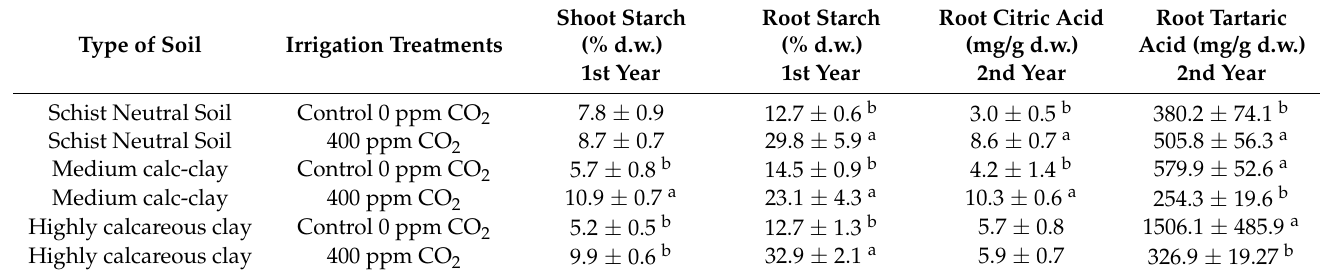
Table 8. Quantitation of shoot and root starch, and citric and tartaric acid in roots of V. vinifera (L.) cv. Tempranillo. Plants in pots with three different substrates. Treatments: schist soil, medium calcareous clay soil (medium calc-clay), and highly calcareous clay soil, treated with non-acidified water (control pH 7.5) and 400 ppm CO 2 -acidified water (pH 6.5). a,b : different letters denote a statistically significant difference ( p < 0.05) between treatment for the same type of soil. Values with different letters denote a statistically significant difference ( p < 0.05). The results show the mean value and standard deviation.